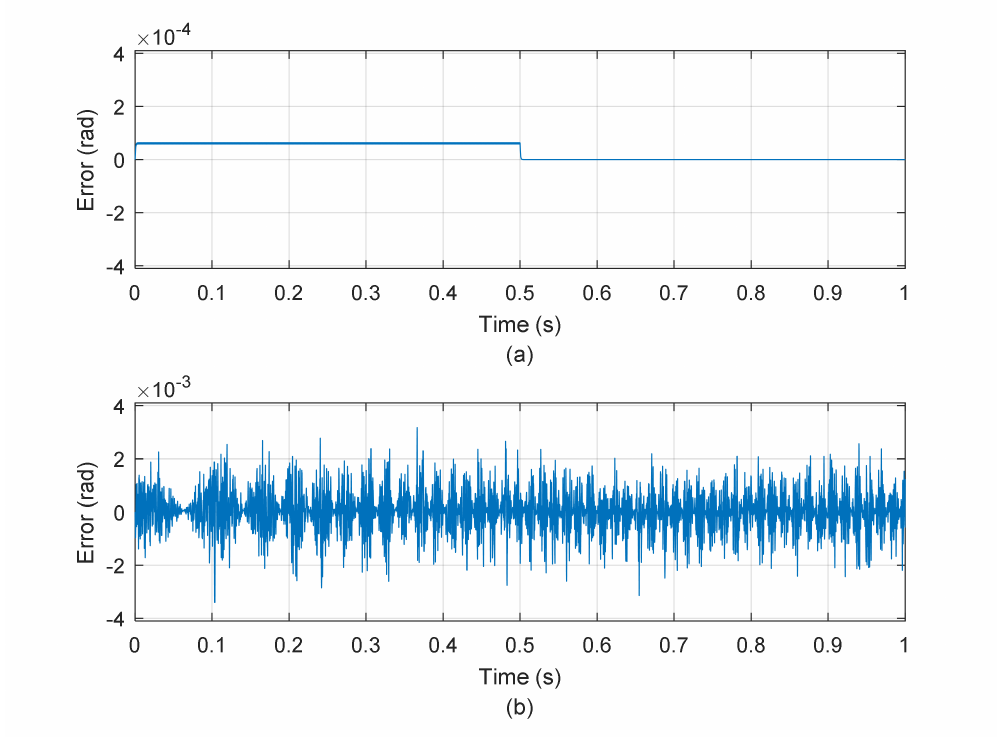
Figure 11. Simulation results for N p = 102, N c = 10, R w = 0.01. ( a ) Without noise; ( b ) with